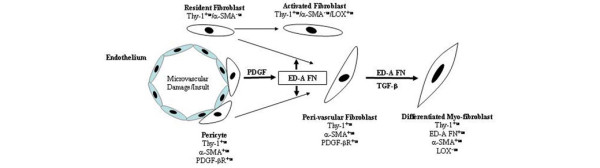
Convergence of microvascular pericytes and resident fibroblasts to a myofibroblast lineage in SSc. Two pathways potentially contribute to the fibrogenic response in dcSSc. Microvascular pericytes (Thy-1+ve /α-SMA+ve ) become activated as a result of microvascular damage and produce the ED-A splice variant of fibronectin, a protein known to induce the myofibroblast phenotype. The microvascular derived ED-A FN in concert with the actions TGF-β may also act upon resident perivascular fibroblasts (Thy-1+ve /α-SMA-ve ) stimulating their differentiation to myofibroblasts. Proliferation of both pericytes and fibroblasts may help to create a pool of potential myofibroblasts. α-SMA, alpha smooth muscle actin; dcSSc, diffuse cutaneous systemic sclerosis; ED-A FN, ED-A splice variant of fibronectin; TGF-β, transforming growth factor-beta.